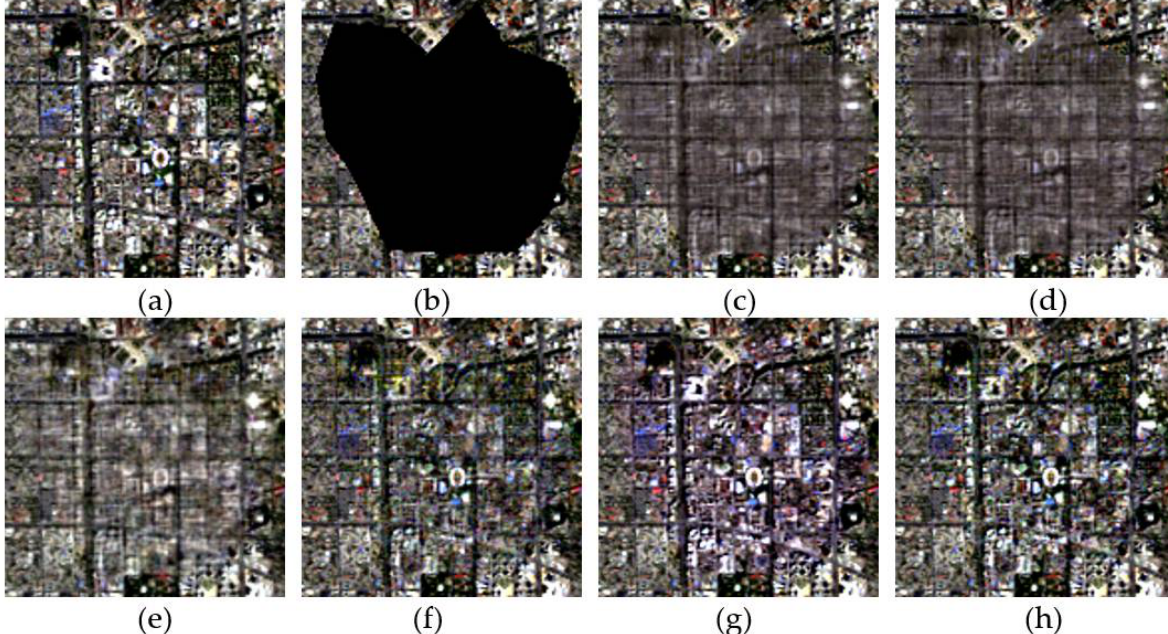
Figure 6. Enhanced details from Figure 5a–h: ( a ) original image; ( b ) simulated cloudy image; ( c – h ) reconstructed images of HaLRTC, AWTC, NL-LRTC, TVLRSD, ST-Tensor and FMTC algorithms, respectively.